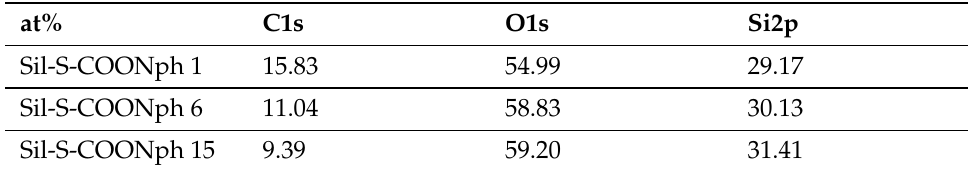
Table 1. Surface elemental composition of 2-naphthalene methanol-containing samples determined by X-ray photoelectron spectroscopy.